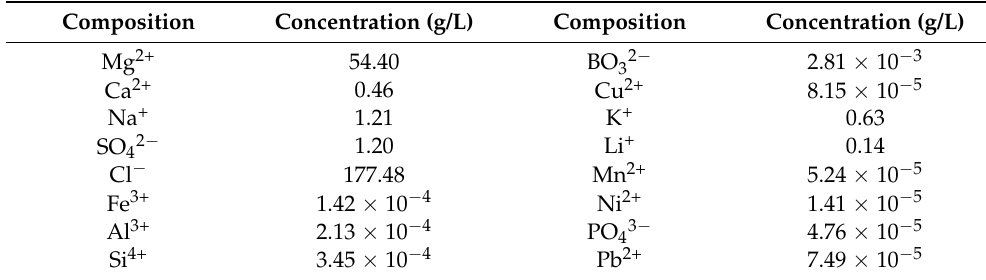
Table 1. The composition analysis of bischofite.